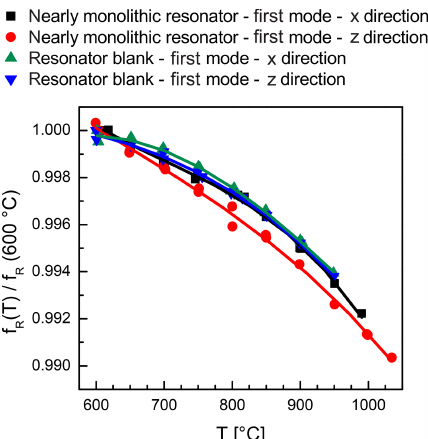
Figure 8. A comparison of temperature dependence of resonance frequency for the nearly monolithic resonator and the resonator blank. Both are measured using electrodes aligned along the x as well as z axis. For comparability all data sets are normalized to the respective value of f R at 600 ◦ C.